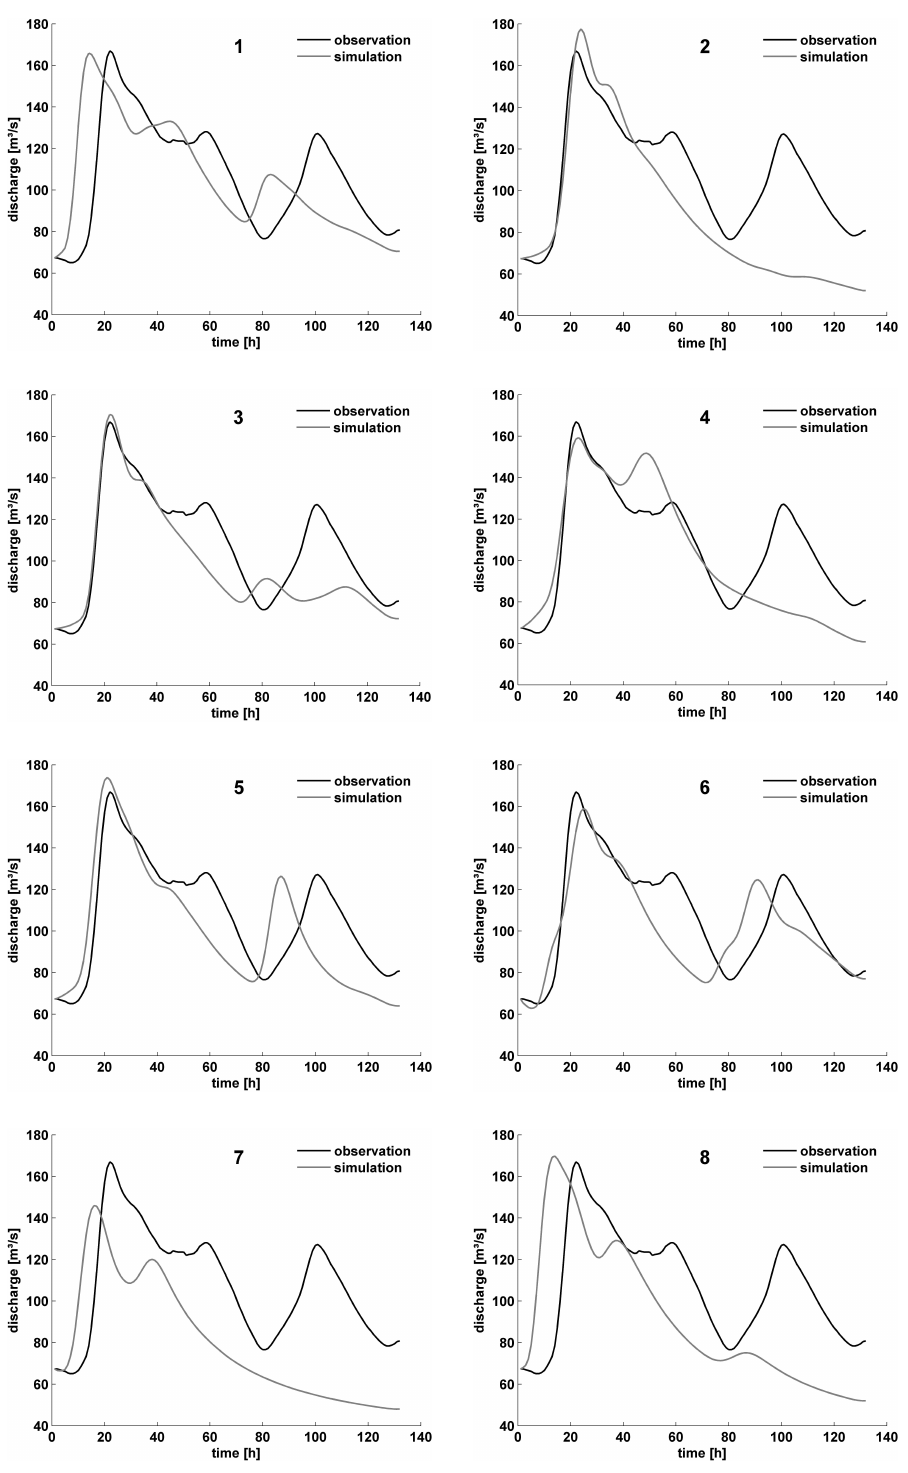
Fig. 4. Observed discharge at gauge Kempten/Iller (954km 2 ) for period 21 April 2008 14:00–27 April 2008 00:00 (132h) and 8 simulations with hydrological model “Fgmod” (Ludwig, 1982) based on Cosmo-Leps ensemble weather forecasts (Marsigli et al., 2005).